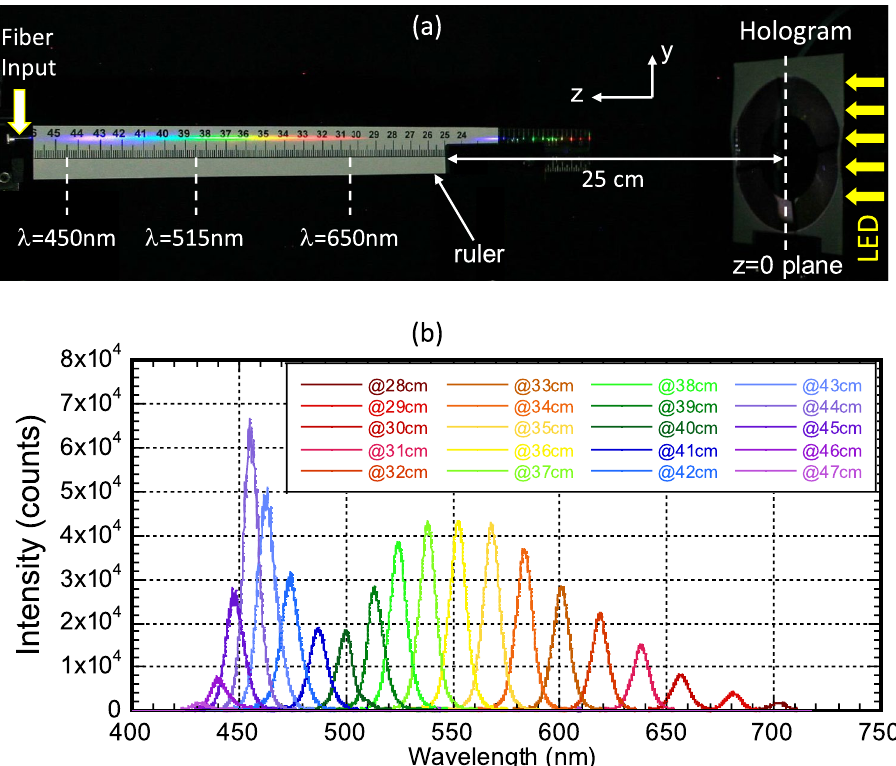
Figure 6. Reconstructed image and spectroscopic measurement of the Fresnel hologram. ( a ) A photo of the reconstructed image using a collimated LED white light. The ruler is placed near the optical axis, z-axis, to illustrate the chromatic behavior. ( b ) A series of spectral curves taken at different positions along the optical axis using an optical fiber of core diameter d = 400